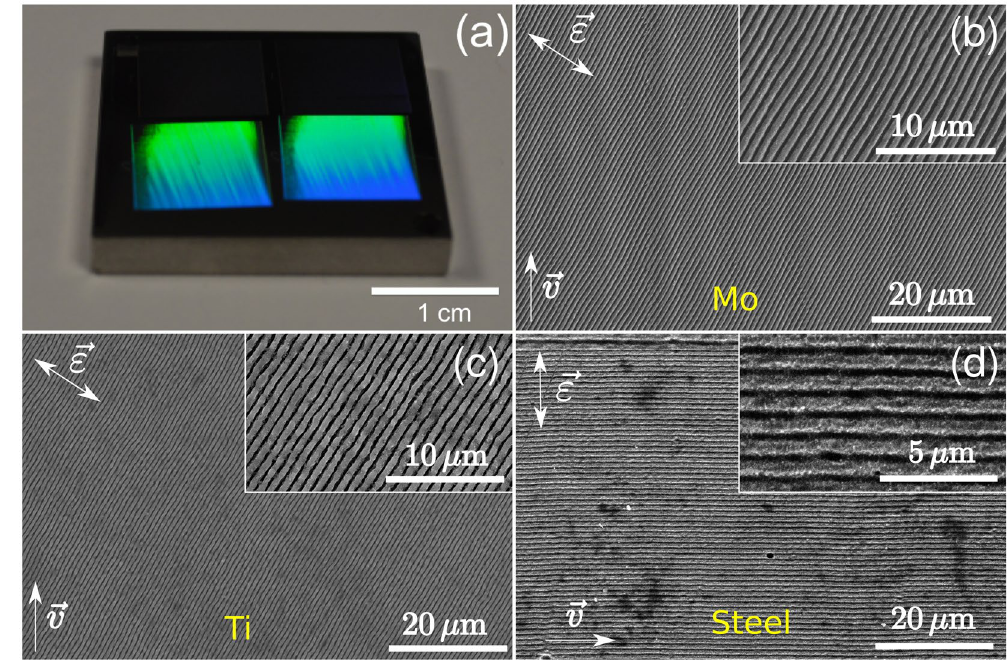
Figure 1. Demonstration of high regularity of LIPSS obtained in this study on several metals. Arrows indicate (cid:31)(cid:30)  v directions of laser field polarization (  ) and laser beam scanning ( ). ( a ) Human-scale view of a stainless steel AISI 316 L sample covered with HR-LIPSS under ambient light conditions of the laboratory. Color arises from the diffraction of ambient light on the nanostructured material. ( b – d ) Respectively Secondary Electron Microscope (SEM) images of the Mo (effective pulse number N ~ 3.7, average fluence F = 0.69 J/cm 2 ), Ti ( N ~ 2.1, F = 0.59 J/cm 2 ), and stainless steel ( N ~ 2.1, F = 0.45 J/cm 2 ) samples covered with HR-LIPSS. Steel comprises iron with 16.87% Cr and 10.05% Ni. Insets in Figs ( b – d ) show magnified views of corresponding images [2 × in ( b ) and ( c ), 4 × in ( d )].